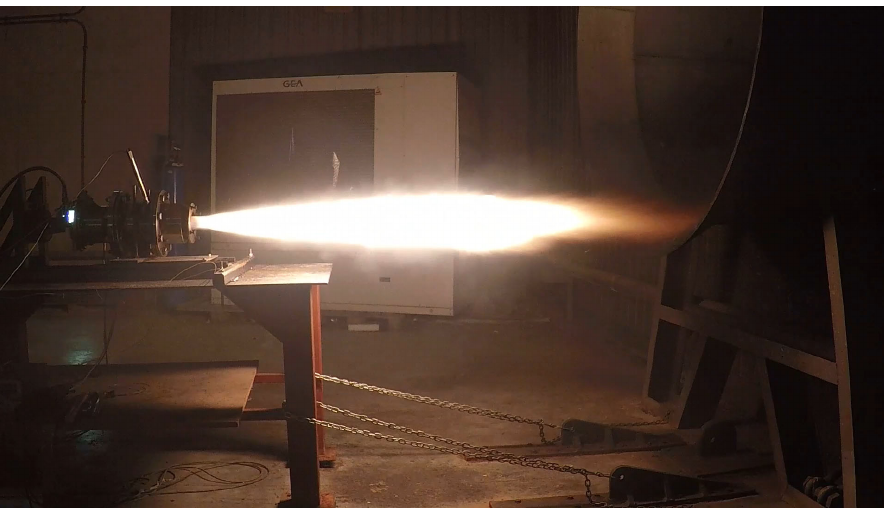
Figure 4. The ULB-HRM during operation